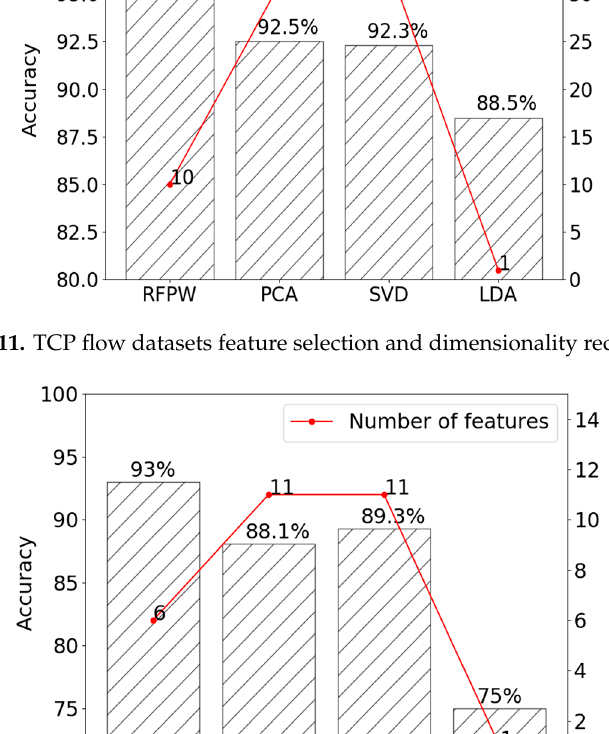
Table 6. Comparison of TCP flow dataset feature selection algorithms. Method